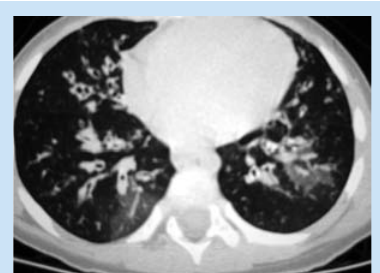
Fig. 10. Parenchymal bands.